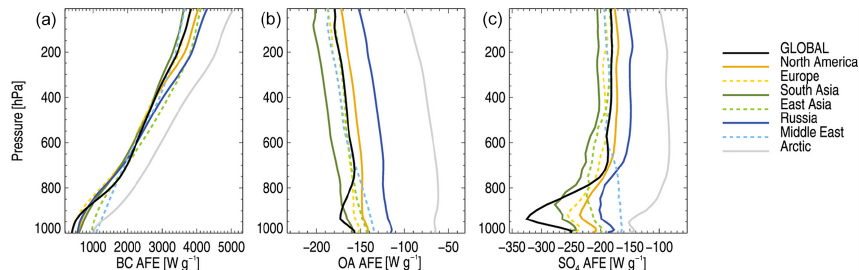
Figure 6. Aerosol forcing efficiency profiles, i.e., TOA radiative forcing exerted per gram of aerosol vs. altitude, calculated by the OsloCTM2 model. Black, solid lines indicate global, annual mean profiles. Colored lines show the annual mean profiles within the regions of Fig. 1a.